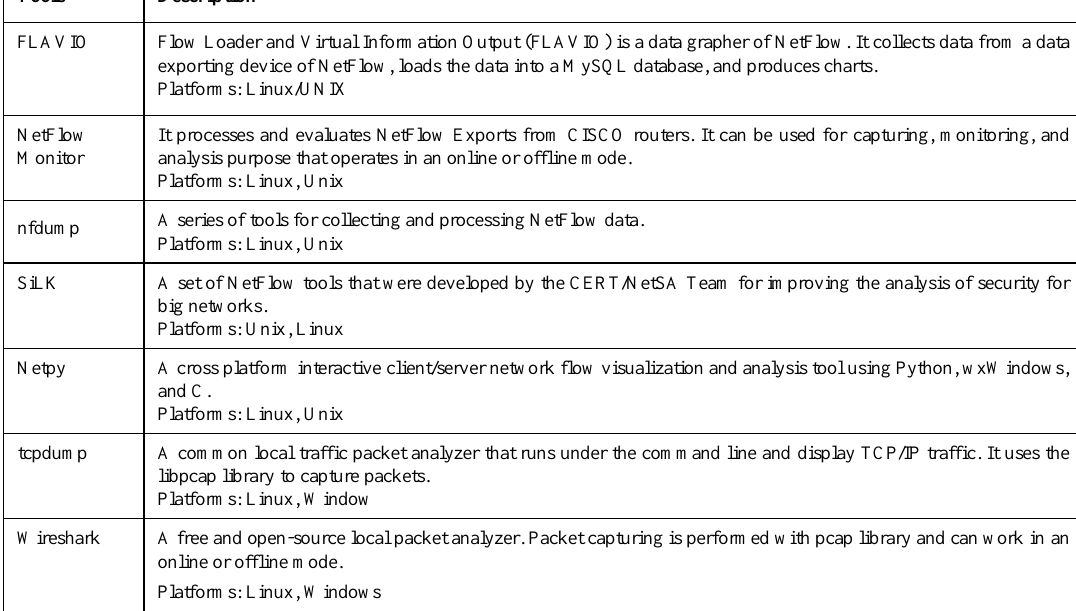
Table 1. Some tools related to network